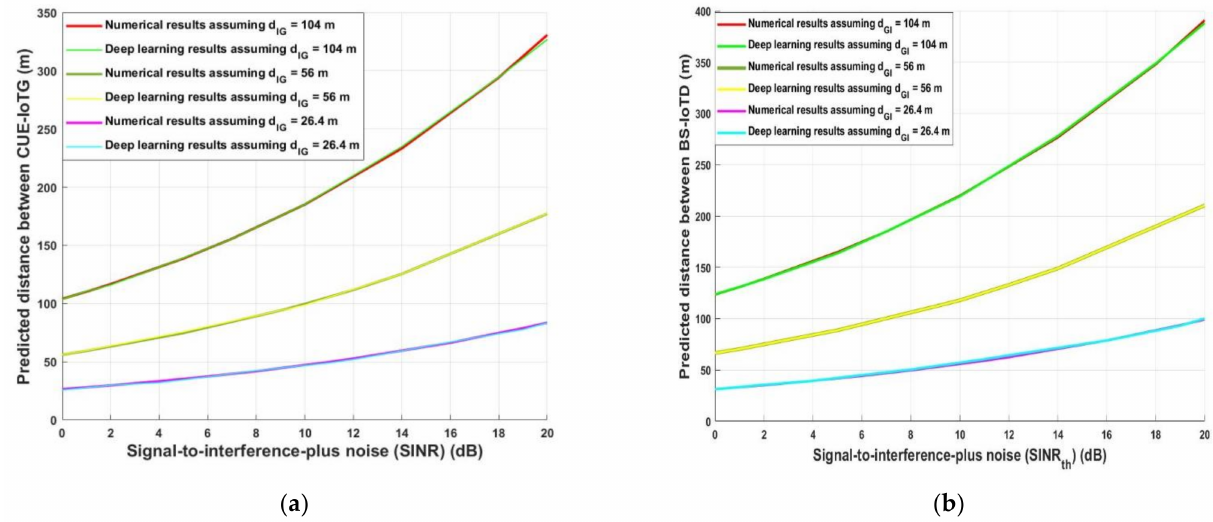
Figure 8. ( a ) Signal-to-interference-ratio-plus-noise ( SINR th ) versus predicted distance between CUE-IoTG (uplink) ( b ) Signal-to-interference-ratio-plus-noise ( SINR th ) versus predicted distance between BS-IoTD